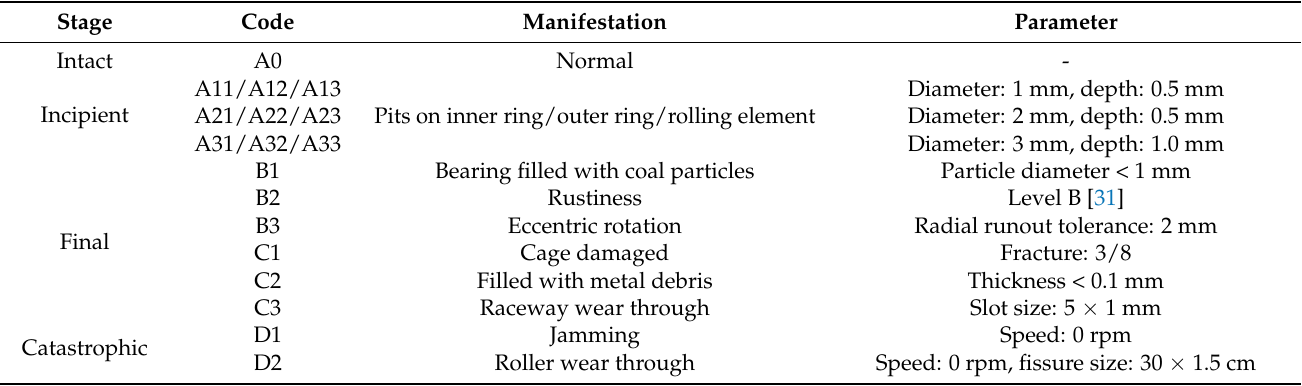
Table 2. Fault descriptions of